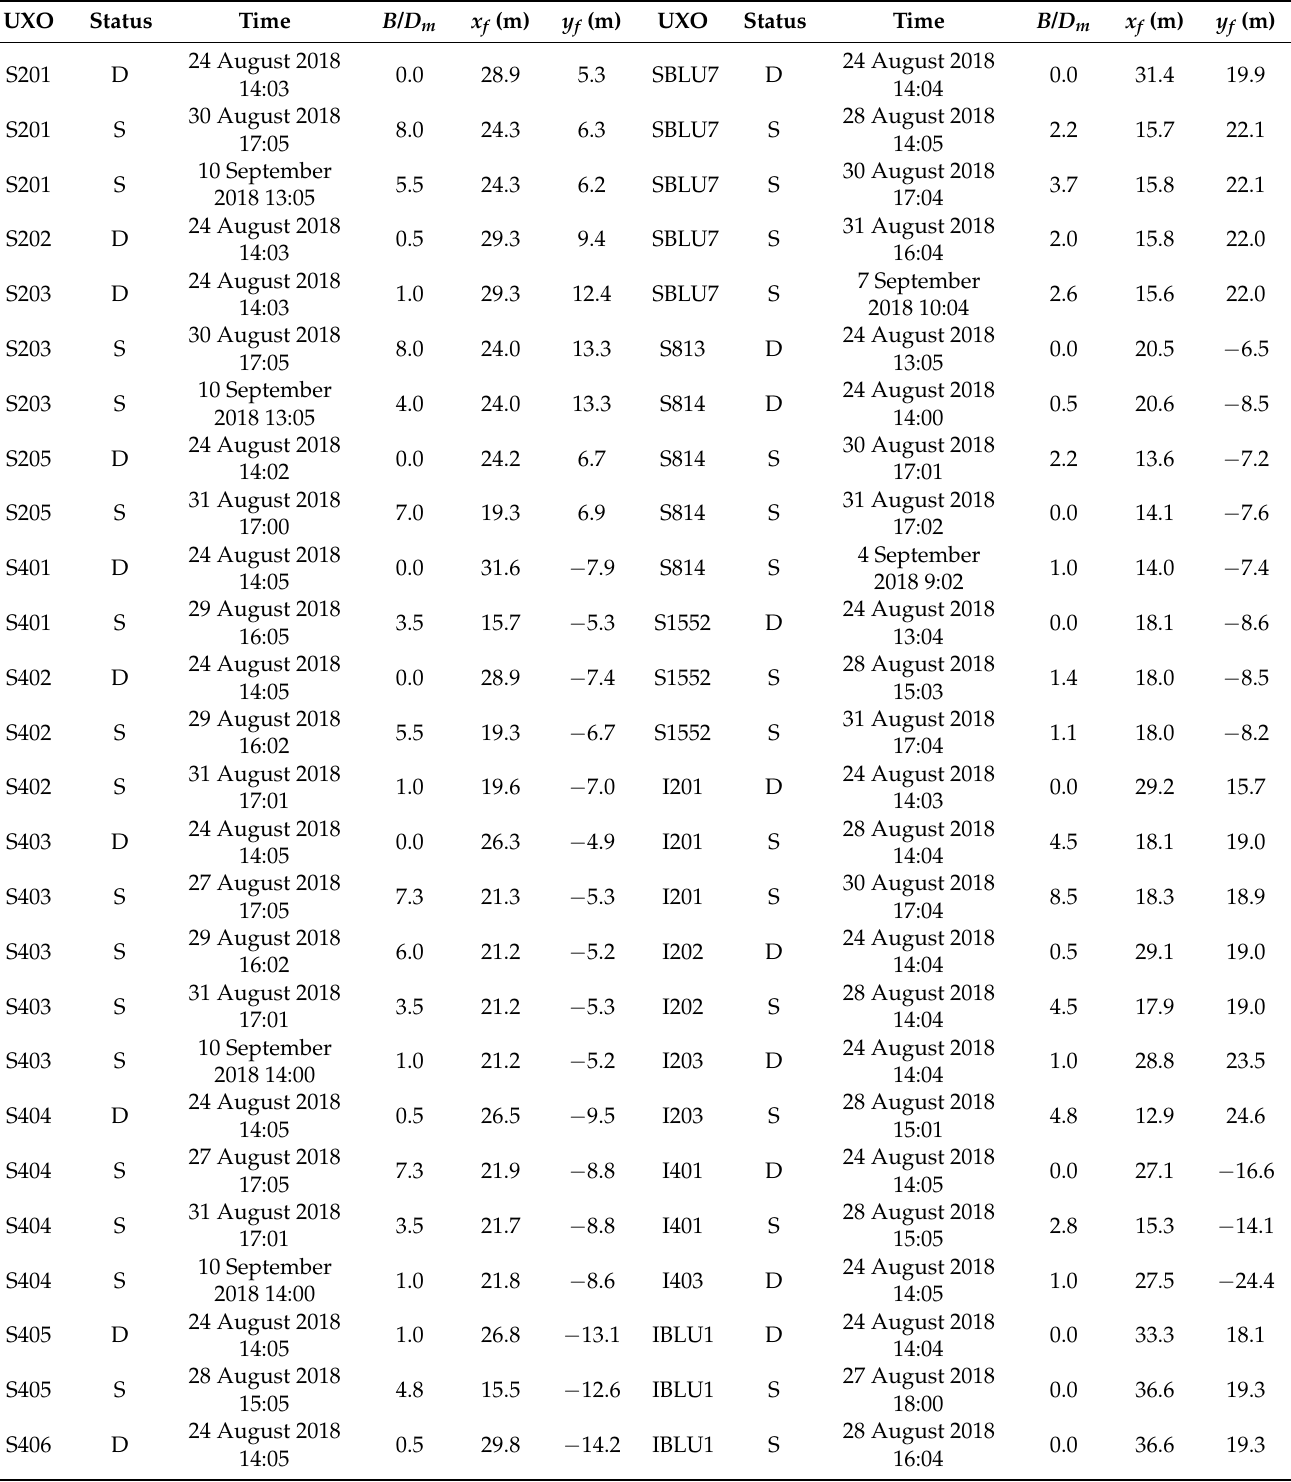
Table A2. Surveys of of x f , y f position and burial relative to local bed level for long term deployed munitions that went lost. The acronyms ‘D’, ‘S’ and ‘R’ stand for Deployed, Surveyed,